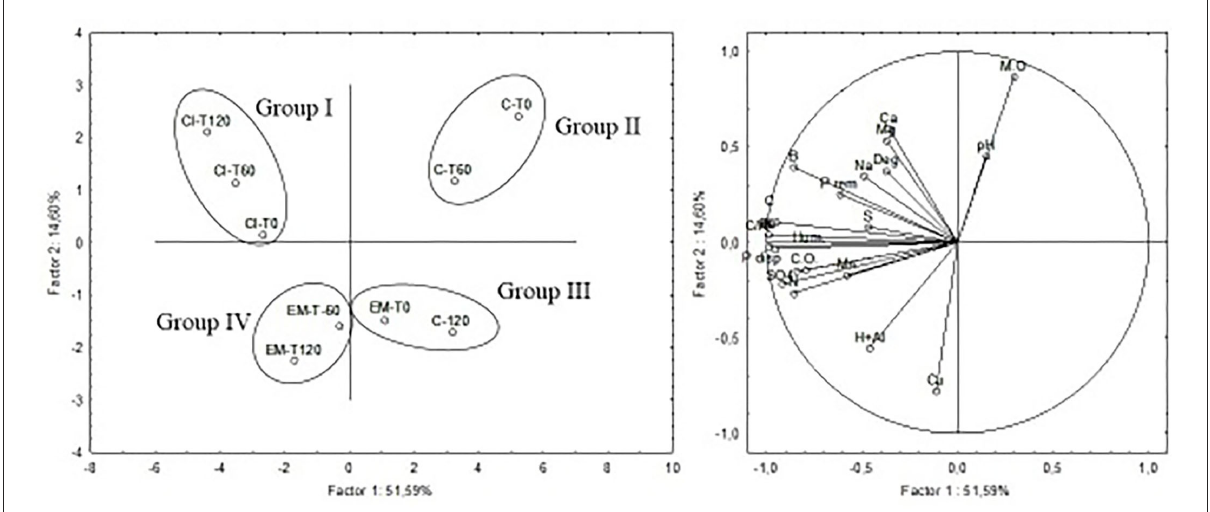
FIGURE3 Analysis of major components of physical and chemical attributes during